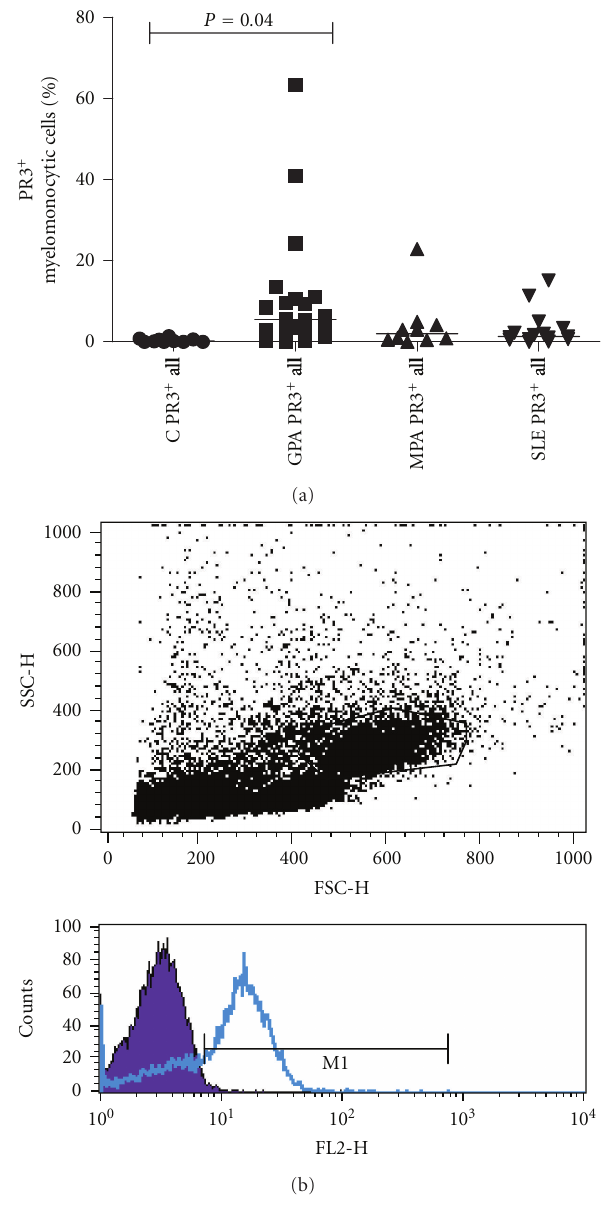
Figure 3: Percentages of all PR3 + myelomonocytic cells. GPA patients displayed higher percentages of cells expressing Proteinase 3. MPA and SLE patients were not di ff erent from controls ((a), bars show median). Images in (b) show representative FACS plots of a patient with GPA. The upper image in (b) displays the gating strat- egy for analyzing myelomonocytic cells, the lower image indicates increased percentages of mPR3 positive cells.